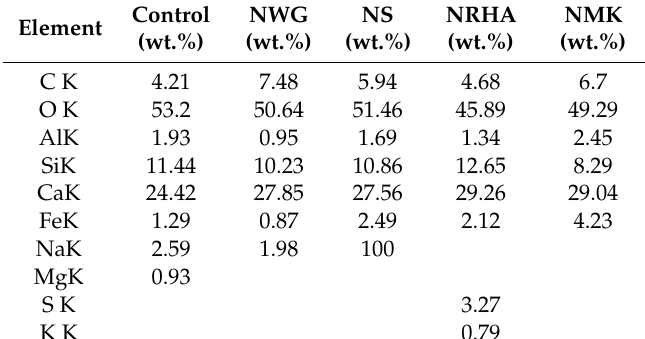
Table 6. Ca/Si ratio of different concrete mixes.